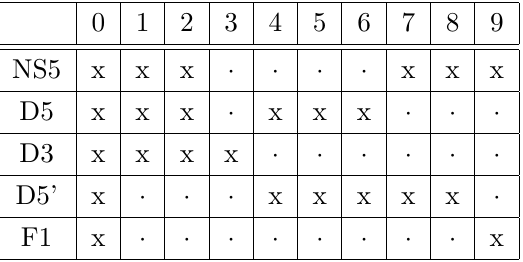
Table 2 . Type IIB brane construction for a Wilson